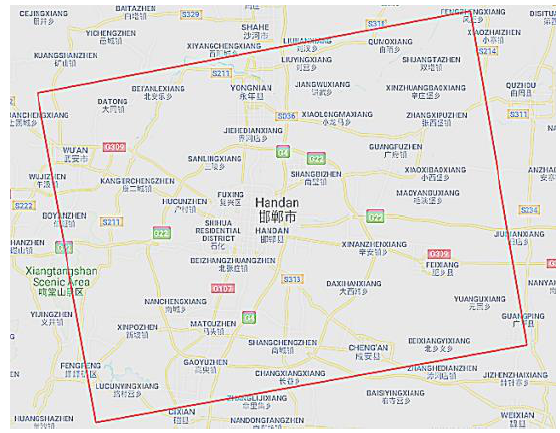
Figure 1. Location of study